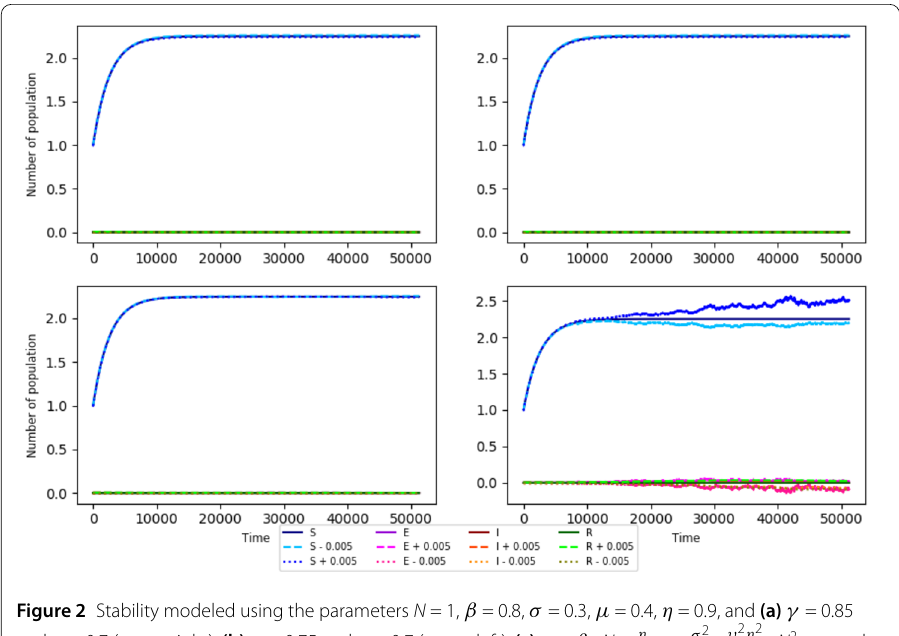
υ 2 η 2 – σ 2 N 2 – μ and ( μ + υ ) 2 μ 2( μ + υ )